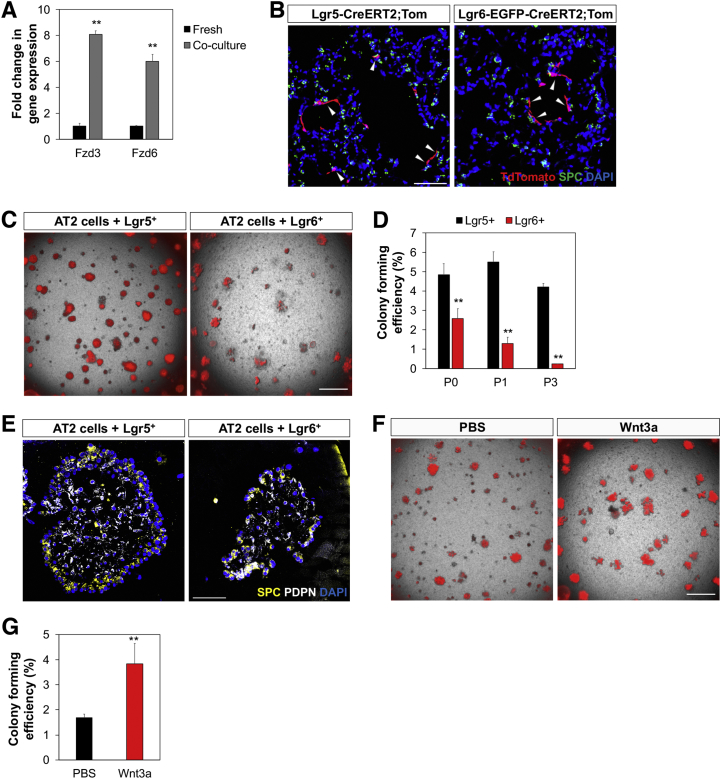
Contribution of Lgr5+ Cells to AT2 Cell Expansion and Differentiation, Related to Figure 7(A) qPCR analysis for the expression of Fzd receptors in freshly isolated Scgb1a1+ cells from lung tissues and separated Scgb1a1+ cells from organoids co-cultured with Lgr5+ cells. Data presented are the mean of two independent experiments with triplicate wells. Error bars indicate standard deviation (∗∗p < 0.005).(B) Representative confocal images showing close interactions of lineage labeled Lgr5+ (left) and Lgr6+ (right) cells with AT2 cells in alveolar compartments: SPC (green), TdTomato (red), and DAPI (blue). Arrowheads indicate lineage labeled Lgr5+ and Lgr6+ cells located closely to AT2 cells.(C and D) Representative bright field-merged images (C) and colony forming efficiency (D) from Sftpc+ cells co-cultured with Lgr5+ (left) or Lgr6+ cells (right) at 14 days in co-cultures. Self-renewal ability of Sftpc+ cells was assessed; primary colonies (passage 0, P0) were dissociated and FACS sorted for EpCAM+Tom+ followed by replating with fresh Lgr5+/Matrigel or Lgr6+/Matrigel mixture for subsequent colony formation bi-weekly (passage 1, P1; passage 2, P2). Data presented are the mean of three independent experiments with triplicate wells. Error bars indicate standard deviation (∗∗p < 0.005).(E) Representative IF images of alveolar organoids from Sftpc+/Lgr5+ (left) and Sftpc+/Lgr6+ (right) co-cultures; SPC (yellow), PDPN (white), and DAPI (blue).(F and G) Representative brightfield-merged images (F) and colony forming efficiency (G) of Sftpc+/Lgr6+ co-cultures with addition of PBS (left) and Wnt3a (right). Data presented are the mean of three independent experiments with triplicate wells. Error bars indicate standard deviation (∗∗p < 0.005). Scale bar, 500um.